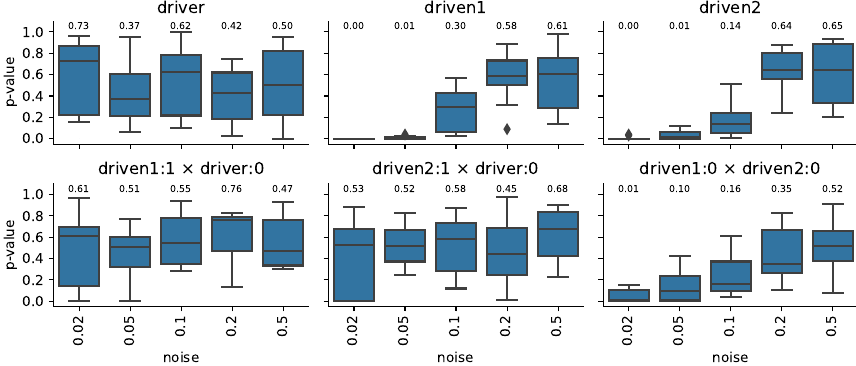
Figure 5. Markov property of the coupled logistic systems with fixed length n = 5000 and various noise. The final p -values of the independence test for the single processes in the upper row, for the joint processes in the lower one for different sample sizes. After the colon symbol, the lag is indicated, the symbol stands for the joint of the two series. The number over the boxes indicates the median